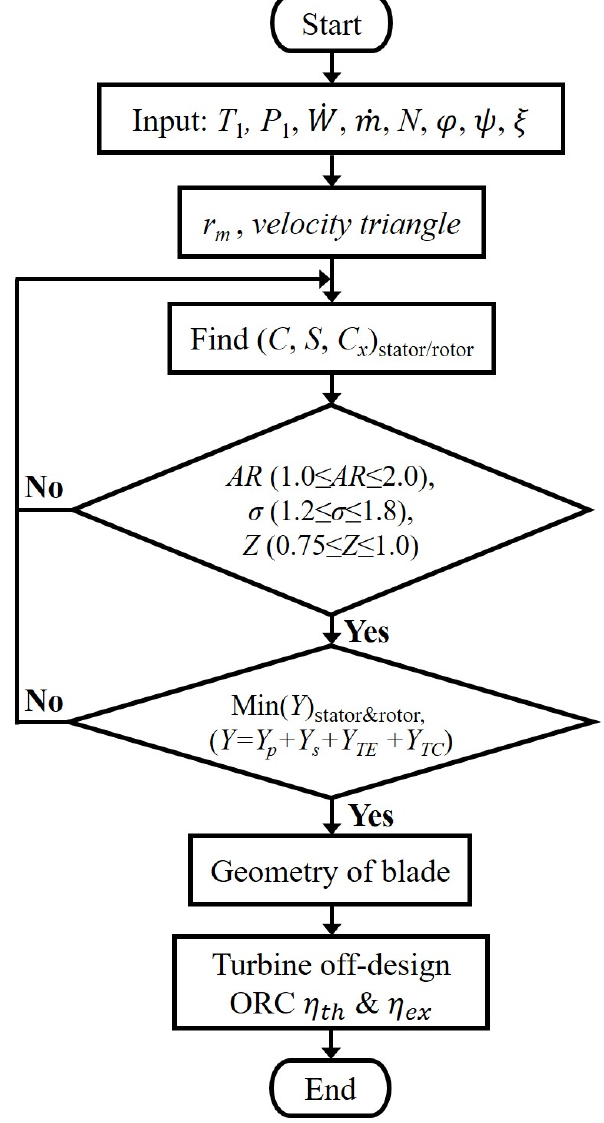
Figure 4. Design procedure flowchart of axial-flow turbine blades for the mean-line.